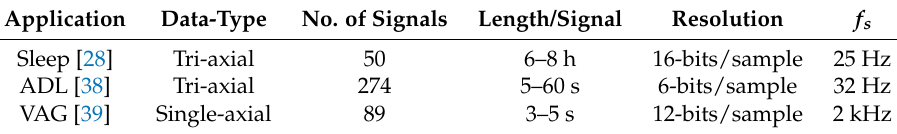
Table 2. Dataset